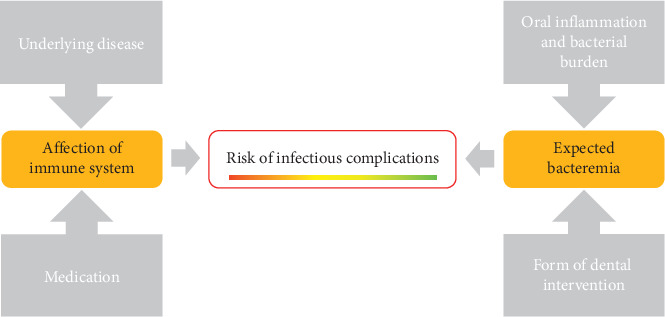
The risk of infectious complications and thus the recommendation of antibiotic prophylaxis can be determined by considering both the effect of the immune system and the level of expected bacteremia.